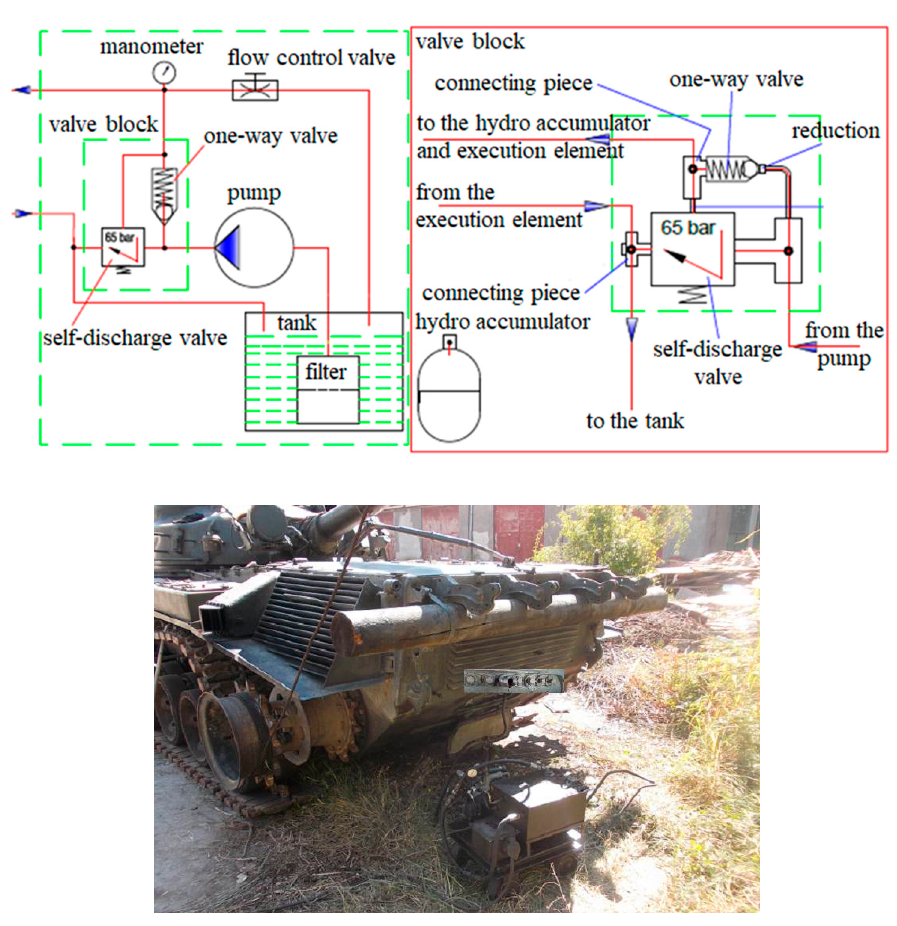
Figure 16. External gearbox coupling system.